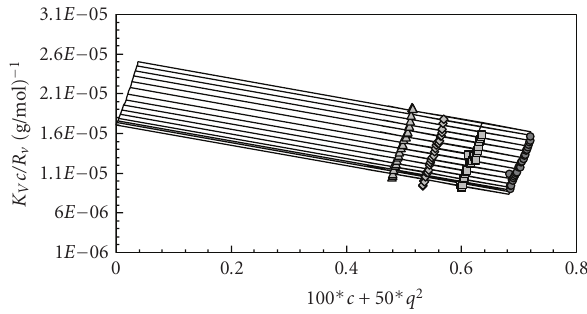
Figure 6: Zimm analysis by a two-power law linear regression (full line) which yields to the molecular size for molecule 2 from both extra polations to q , c → 0. M W = 5 . 93 10 4 Dalton and (cid:3) R 2 43nmA 2 = − 6 . 4 10 − 4 molml/g 2 ( (cid:3) ) = 6.82 10 − 3 g/ml; ( (cid:2) ) = 5.97